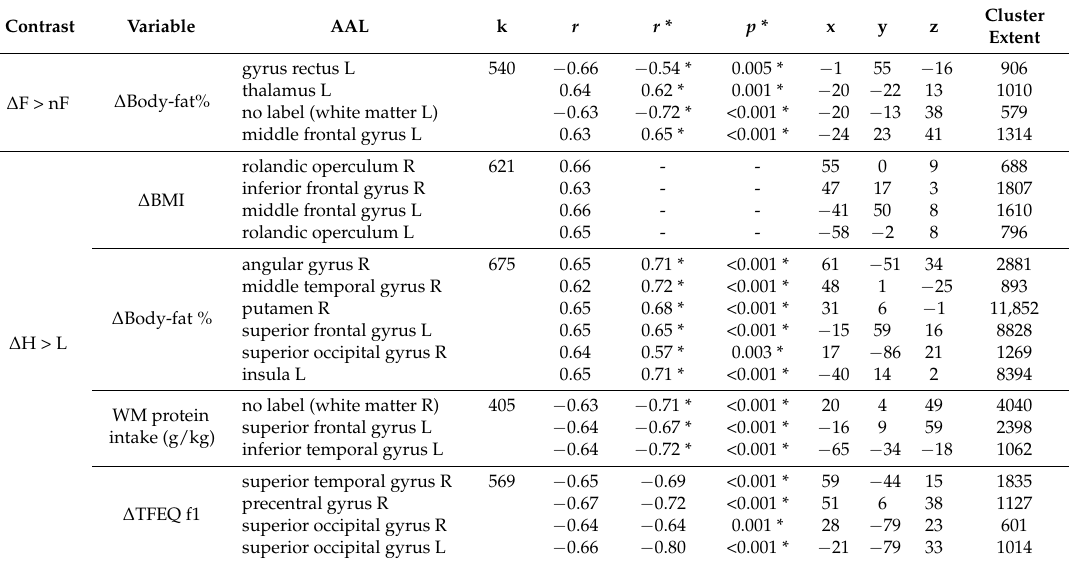
Table 2. Summary of whole brain fMRI results.